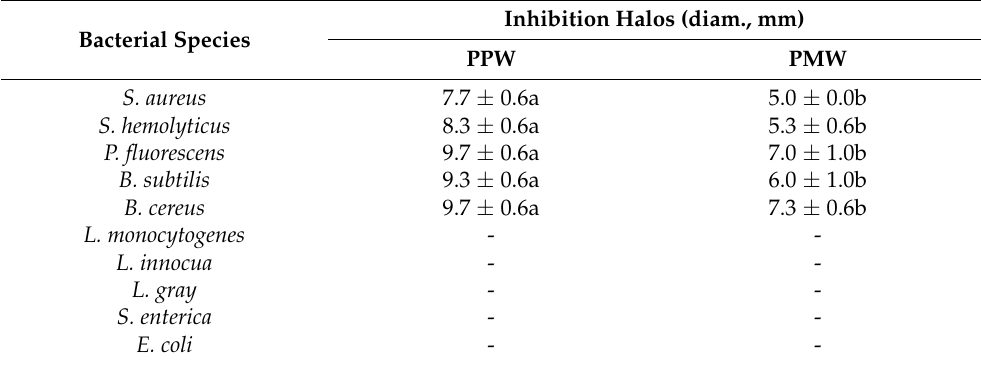
Table 3. In vitro antimicrobial activity of pomegranate peel water (PPW) and pomegranate mesocarp water (PMW) extracts against different bacterial strains. - = no inhibition